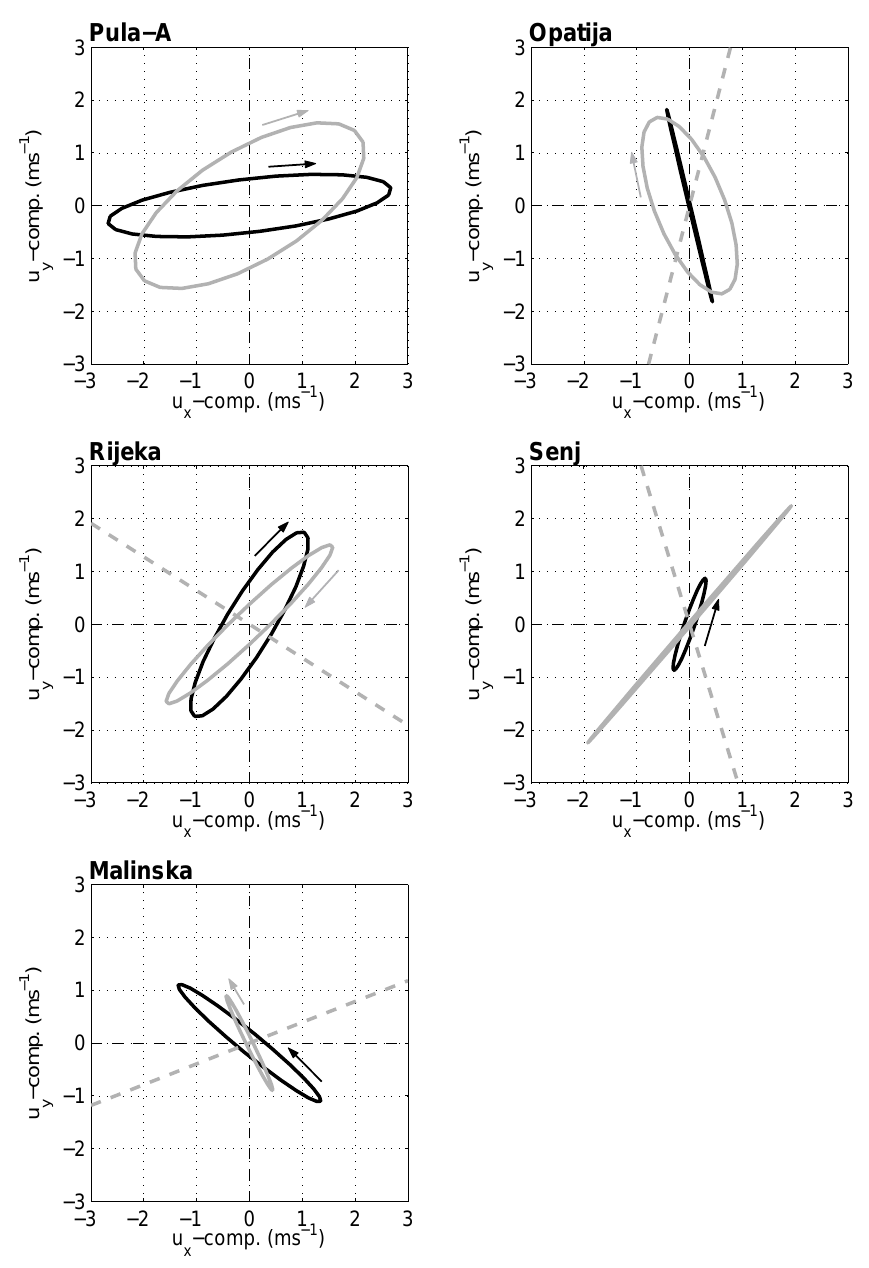
Fig. 5. The 24-h wind ellipses for the selected stations and the corresponding grid points from the inner domain during 18–20 June 2000 (A T1 case): measurements (black) and model (grey). The arrow indicates sense of rotation of the wind vectors (omitted in case of highly polarized ellipses, e.g. for Opatija and Senj). The dashed line represents the orientation of the local coastline. The exception is Pula-airport, which is situated at the tip of Istria peninsula with the nearest coastline being 10km